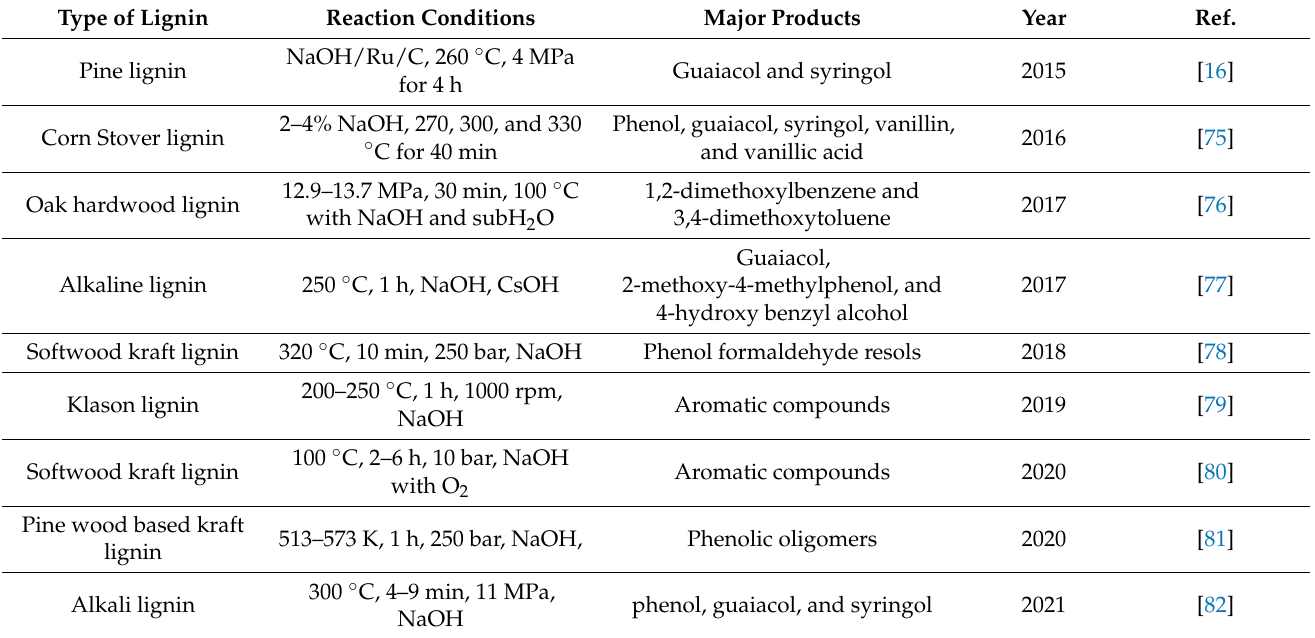
Table 3. Base-catalyzed depolymerization of